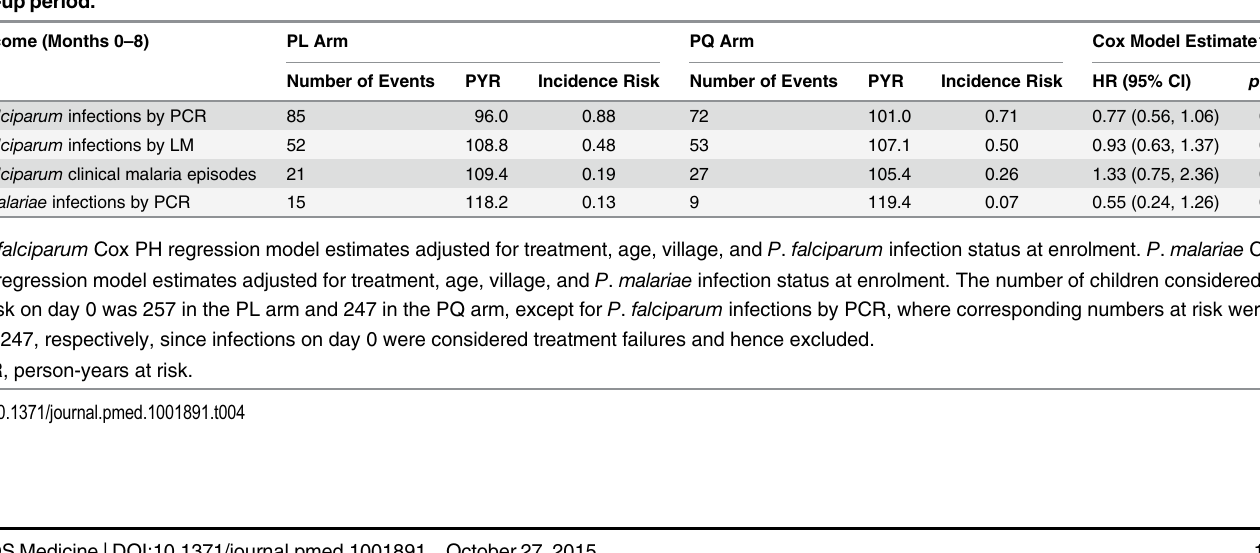
Clinical malaria episode IRRs are derived from a NB reg adjusted for treatment, age, and P . vivax positivity by PCR at enrolment. Other IRRs are derived from a NB reg model adjusted for treatment, age, village, and P . vivax positivity by PCR at enrolment. The number of children considered at risk on day 0 was 245 in the PL arm and 253 in the PQ arm. The number of children considered at risk on study day 96 was 207 in the PQ arm and 205 in the PL arm. PYR, person-years at risk.